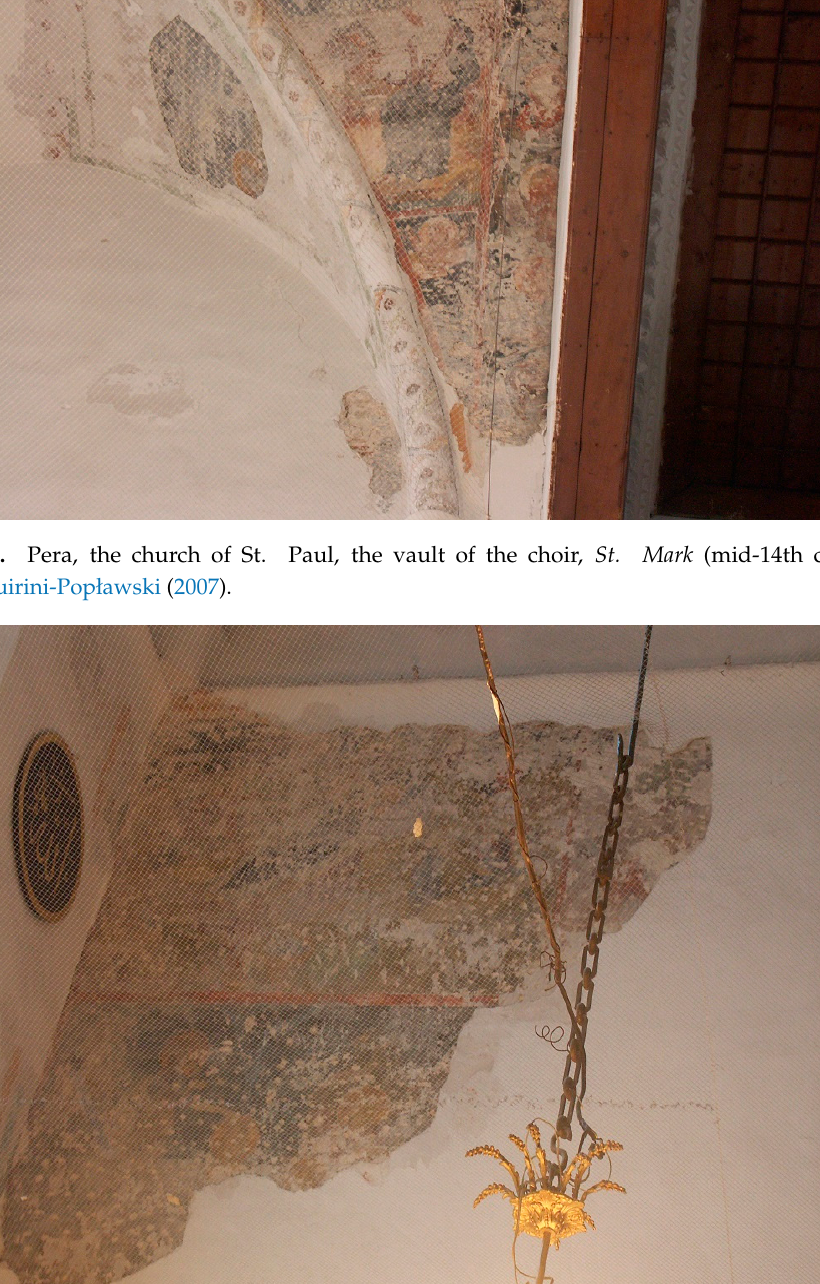
Figure 4. Pera, the church of St. Paul (first quarter of the 14th century), vault of the choir, fot. R. Quirini-Pop ł awski (2007).